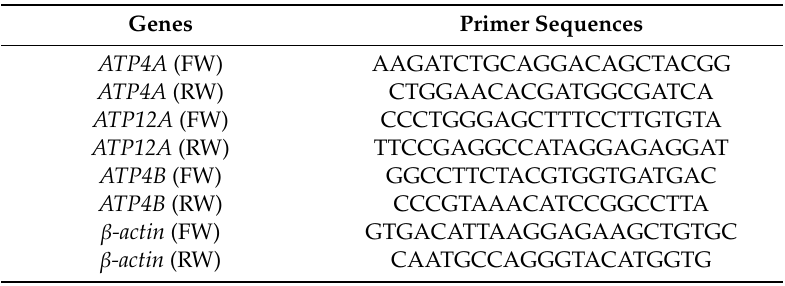
Table 2. Primer sets used for RT-PCR and real-time